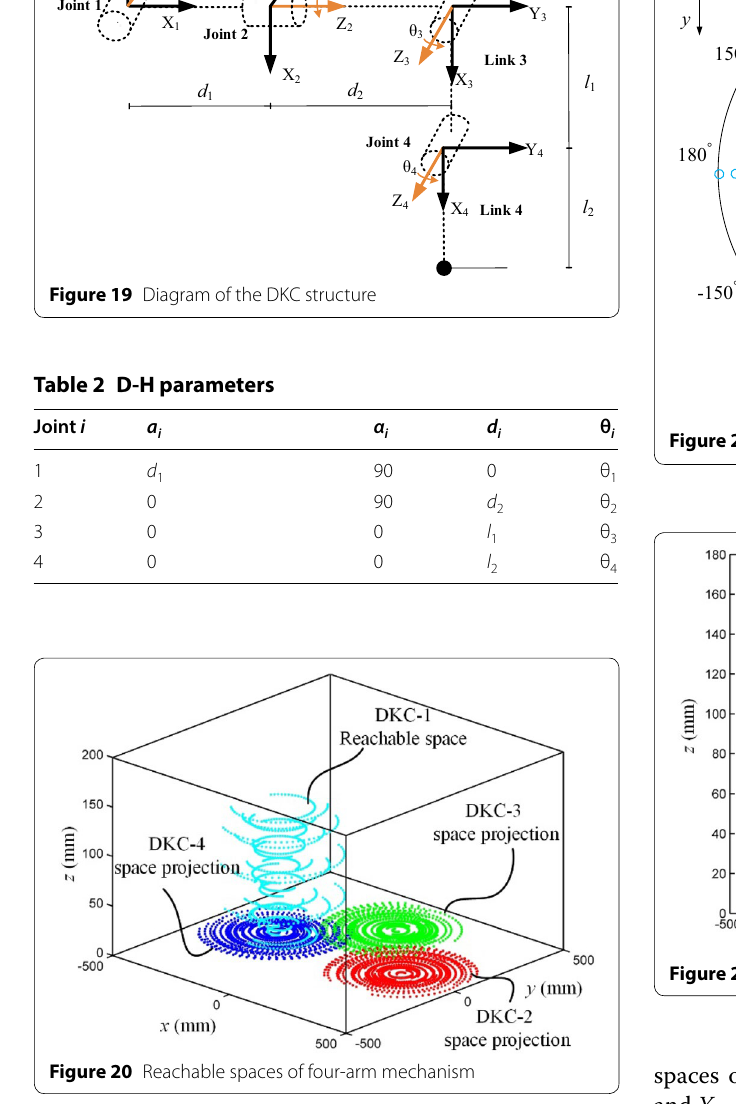
Figure 21 is the top view of the reachable space projec- tion. In this figure, the red points are the points in reach- able space. The black circle is the measuring circle with r 100, 200, 300, 400 mm. The yellow circle is the effec- = tive circle, and its radius is the distance between the min- imum reachable point and the center point.